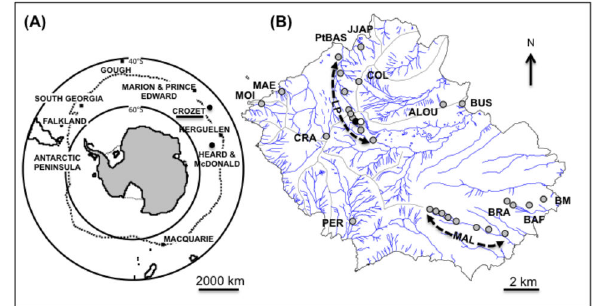
Figure 1. Sub-Antarctic Islands and study sites. Location of Crozet archipelago within the sub-Antarctic region ( A ), geographical location of the 30 sites sampled on Possession Island that belongs to Crozet archipelago ( B ). The sites are represented by dots and dotted lines along two altitudinal gradients: Labourage-Pâturage (LP, n = 9 sites), Malpassée (MAL, n = 8 sites). Other abbreviations on the map: ALOU = Crête de l’Alouette, BAF = Base Alfred Faure, BM = Baie du Marin, BRA = Mont Branca (200 and 300 m), BUS = Baie Américaine, COL = Col, CRA = Mont des Cratères, JJAP = Jardin Japonais, MAE = Mare Aux Éléphants, MOI = Moines, PER = Pérouse, PtBAS = Pointe Basse. The black and the white dots indicate the two habitat types, M1 and M2 respectively, that were sampled at LP 550 m (see Fig.